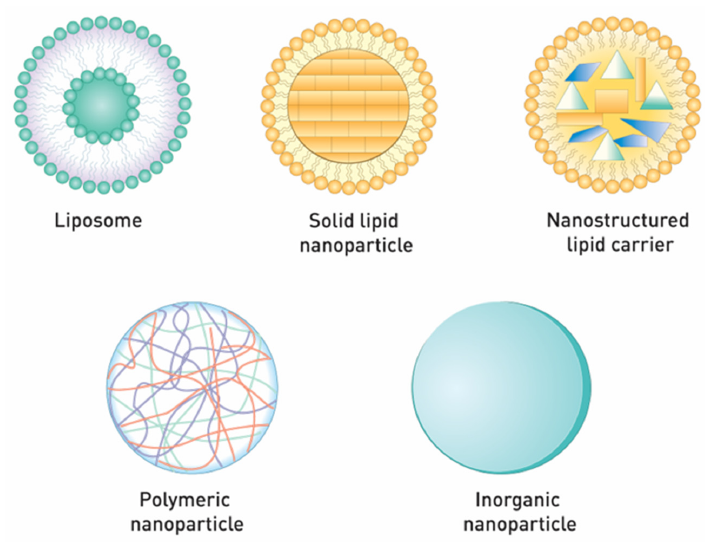
Figure 4. Types of nanoparticles for topical insulin delivery.